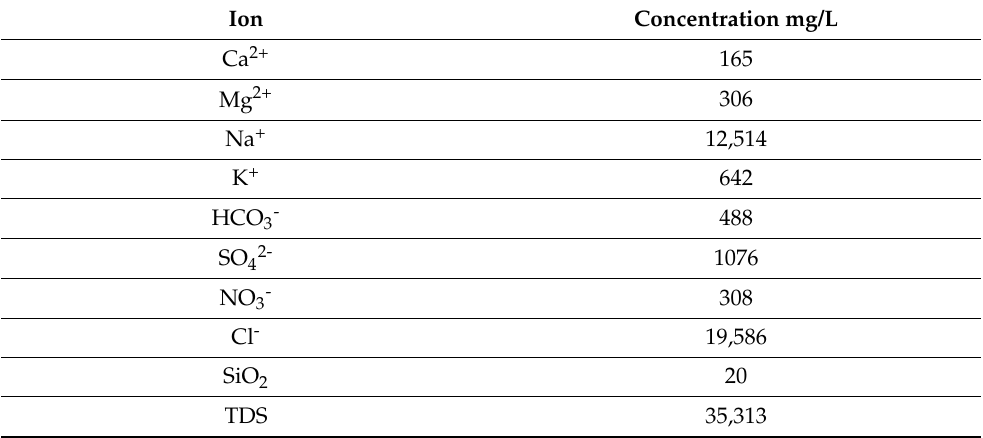
Table 2. Feed water inorganic composition.